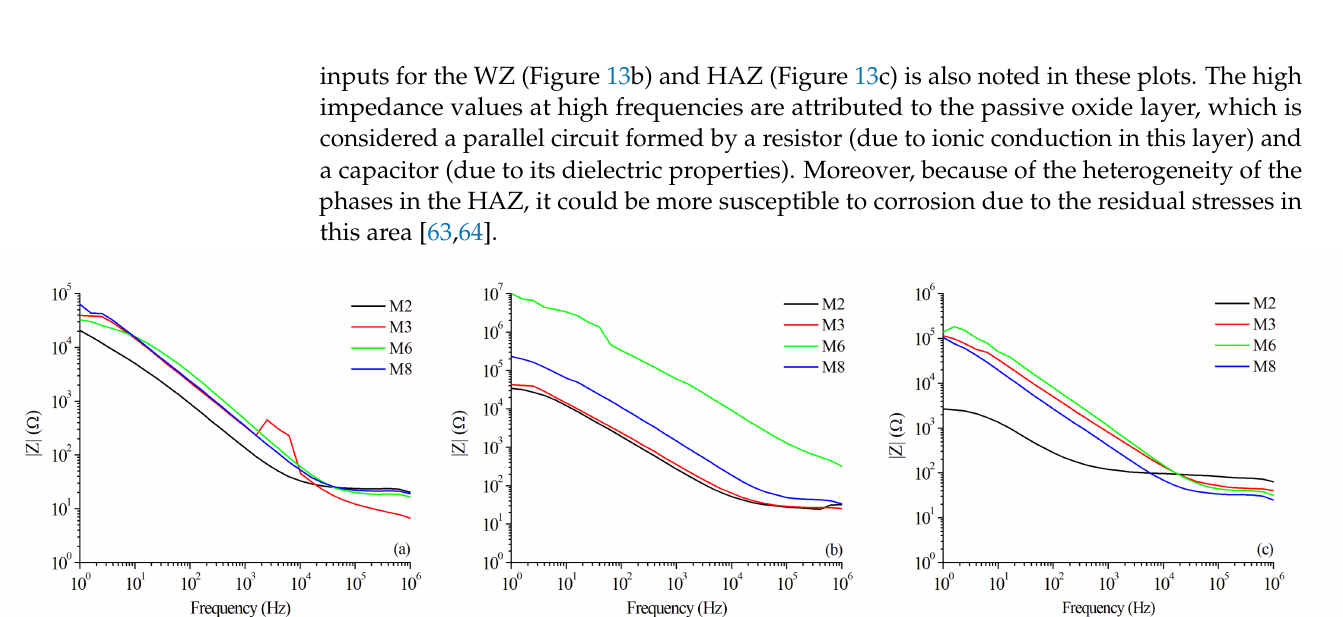
Figure 13. Magnitude in Bode plots for selected samples in different zones: ( a ) Base Metal, ( b ) Weld Zone, and ( c ) Heat-Affected Zone.